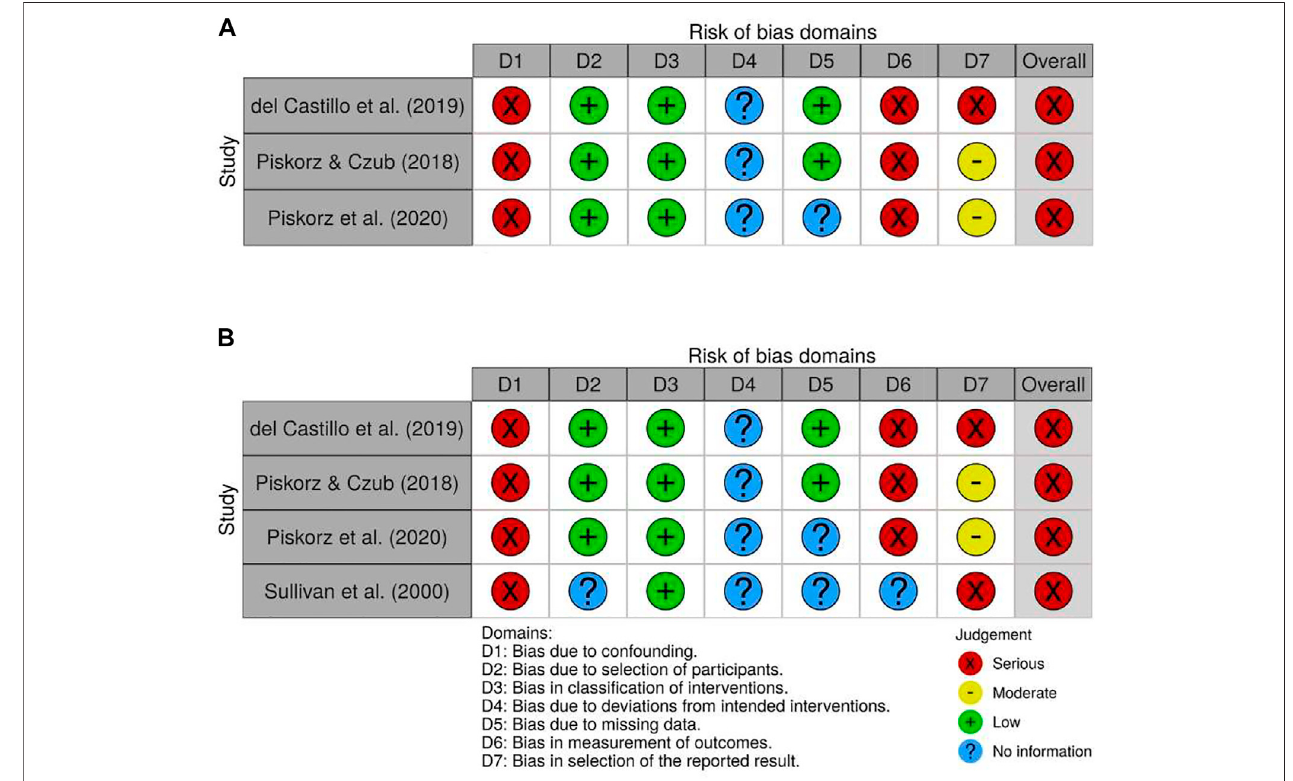
FIGURE 5 | Individual risk of bias judgements of non-randomized studies reporting pain (A) and anxiety (B) outcomes.